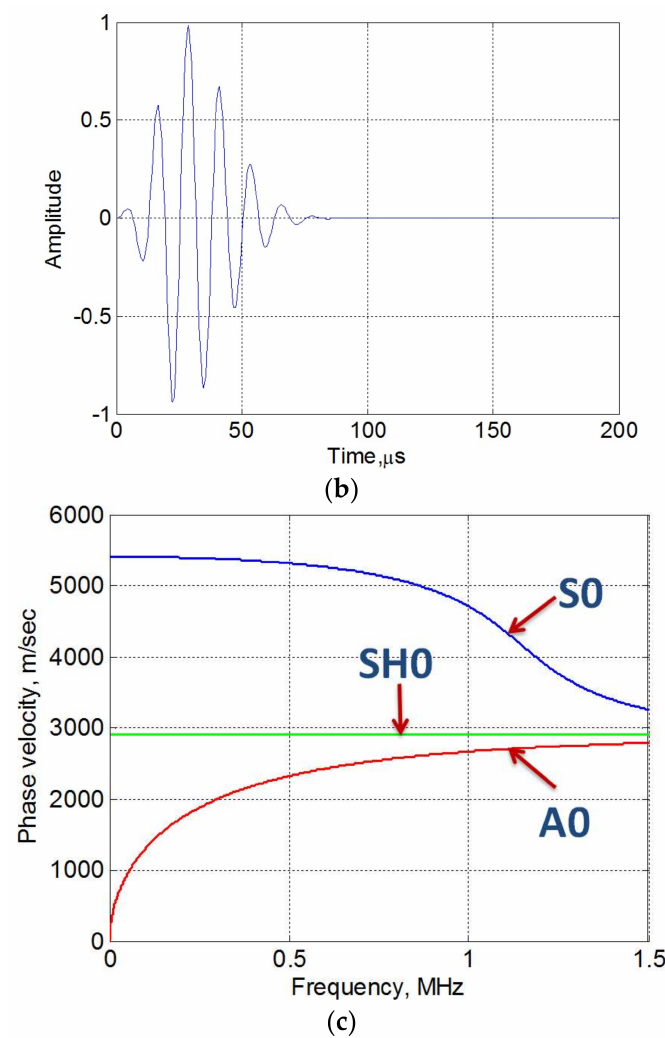
Figure 3. MFC transducer and guided waves: photo of P1-type MFC transducer ( a ), excitation signal of 80 kHz, 5-period burst ( b ) and phase velocity dispersion curves of GW modes in 2 mm thick Al alloy plate ( c ). The MFC transducer was divided into 29 equal segments along its length (28 mm) with a separation distance of 1 mm. Each segment was analyzed as the 15 point sources along the width (14 mm) of MFC which lead the total number of point sources along the structure equal to 435. On another hand, total 181 arbitrary receiving elements placed at a distance of 300 mm from the center of MFC were located along the half-circle at the angular positions varying from 0 ◦ to 180 ◦ . The attenuation coefficient α ( f ) was assumed to be zero for the Al (isotropic and lossless medium) plate. The correction factor ( C F ) to be included for the specific mode is described in Figure 4. Figure 4a illustrates that the particle displacements in both halves of the P1-type MFC are in opposite direction along its length (in y -axis) due to its operation in elongation (d33) mode. Hence the approximated value of the amplitude factor ( A F ) was assumed to be equal to 1 and − 1 at the edges of MFC (all point sources of first and last line segments) along its length ( y -axis) which was decreased linearly towards the axis (center of MFC) where its value was set to zero